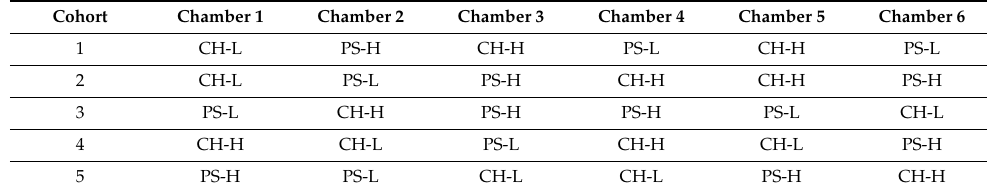
Table 2. Blocking structure and treatment allocation to chambers for each of the 5